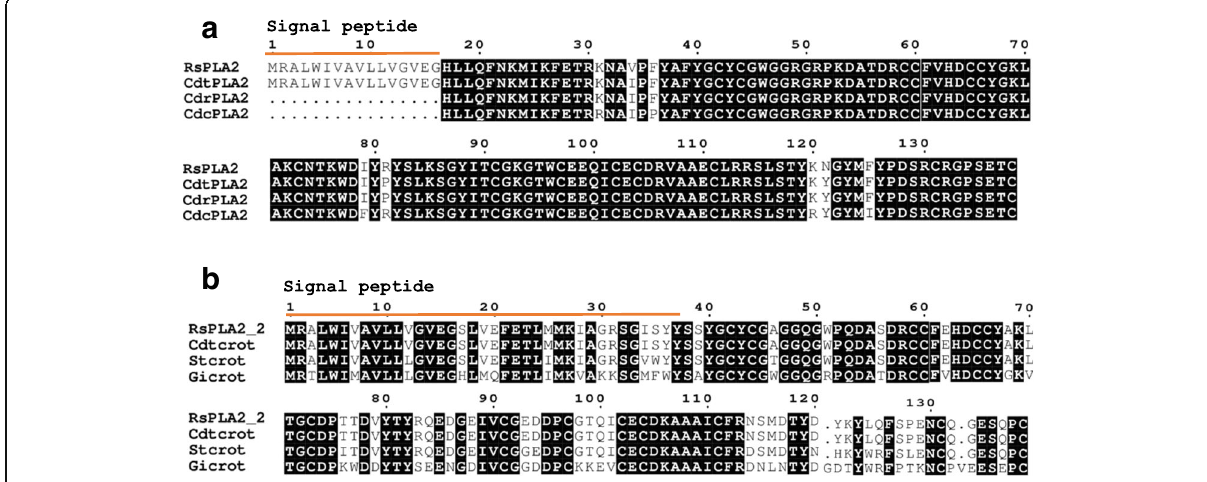
Fig. 1 Sequence alignment of phospholipases A 2 discovered in this transcriptome (RsPLA 2 ) and those available in databases. a Alignment of protein codified by contig TRINITY_DN72825_c0_g1_i2, named RsPLA2 and different basic crotoxins subunits from Crotalus durissus terrificus CdtPLA 2 (PA2B6_CRODO), Crotalus durissus collilineatus CdcPLA 2 (PA2B6_CRODO) and Crotalus durissus ruruima (PA2BA_CRODR). b Alignment of protein codified by contig TRINITY_DN72825_c0_g1_i1, named RsPLA2_2 and different acidic crotoxins subunits, also known as crotapotin, from Crotalus durissus terrificus Cdtcrot (PA1A_CRODU), Sistrurus tergeminus Stcrot (PA2A_SISTE) and Gloydius intermedius Gicrot (A0A096XPP1_GLOIT). Signal peptide is indicated by the orange line above the sequences. Alignment was generated with the aid of Multalin and formatted using Espript